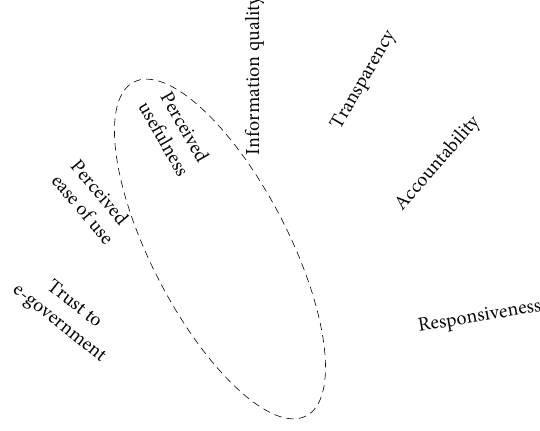
Figure 6: Path 3 contributes to low e-government participation (LEP) ( consistency = 0 : 982 and coverage = 0 : 795 ). Note: the dotted ellipse represents the absence of the condition. If no ellipse displayed, it belongs to the “ do not care ” condition.